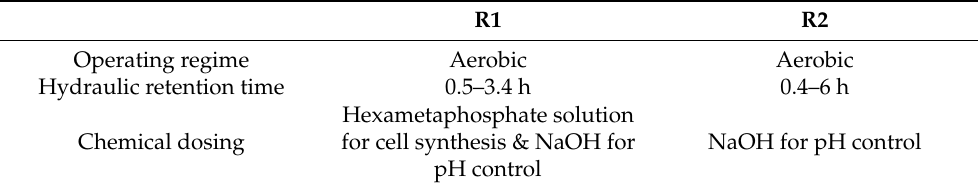
Table 3. Operating conditions in the full-scale plant (compilation of 3.5 years of operation).